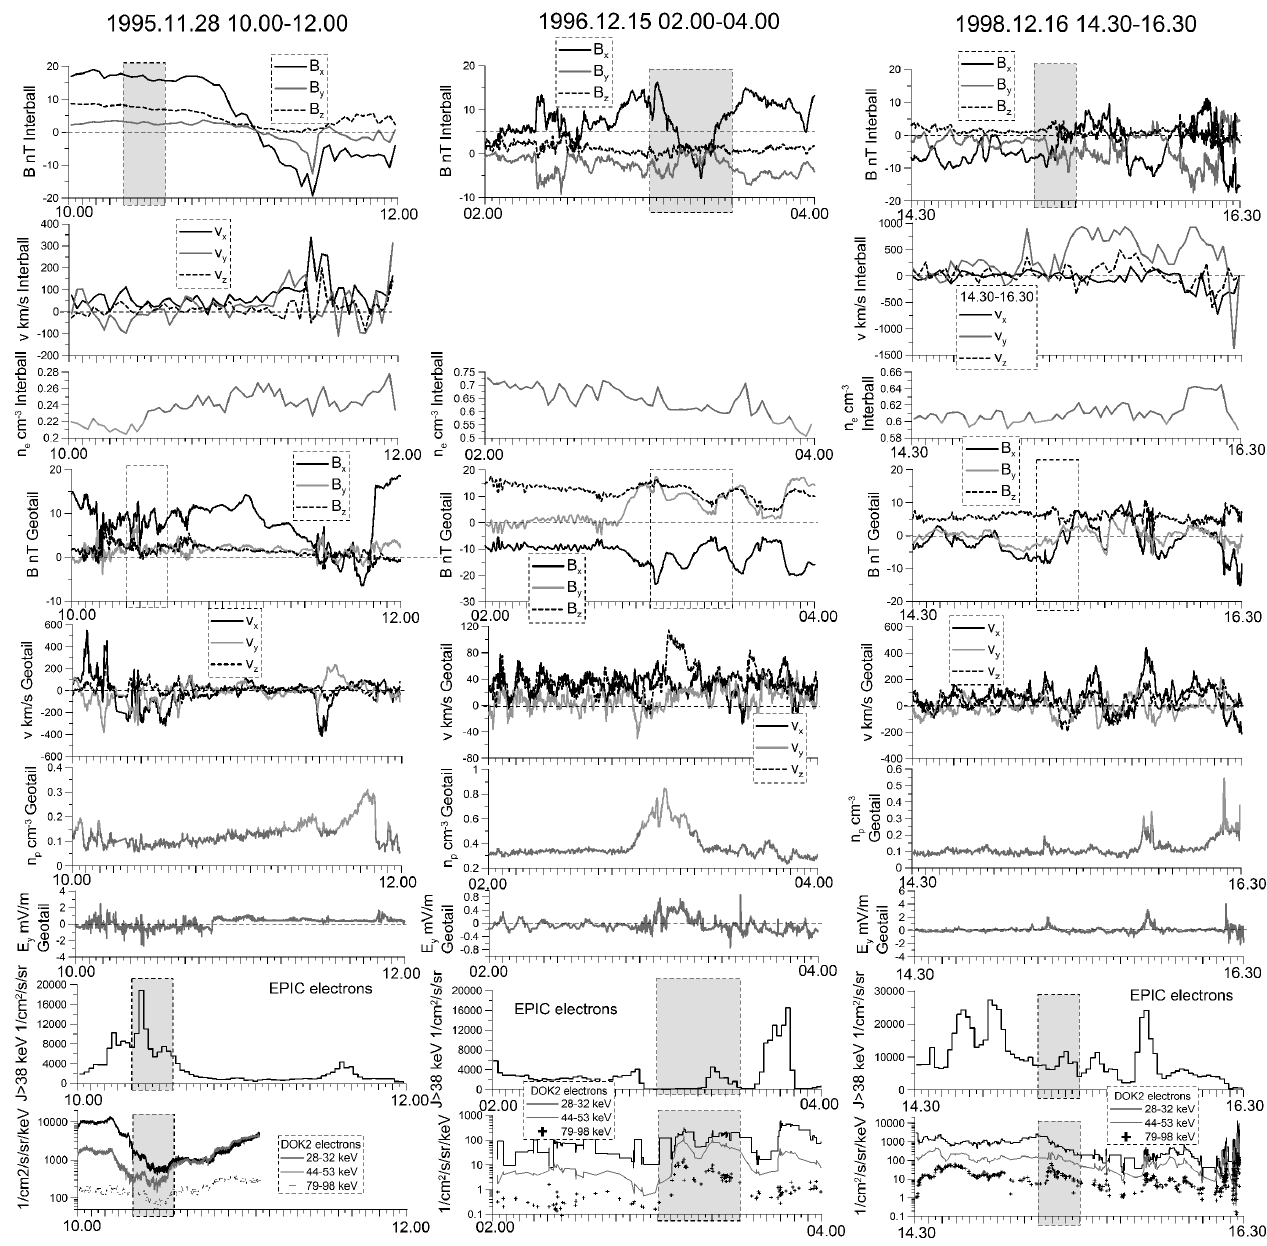
Fig. 8. Magnetic field, ion moments and electron density from Interball-tail and Geotail spacecraft. Fluxes of high-energy electrons from EPIC and DOK2. Periods of observations of double power-law spectra are shown by the colour